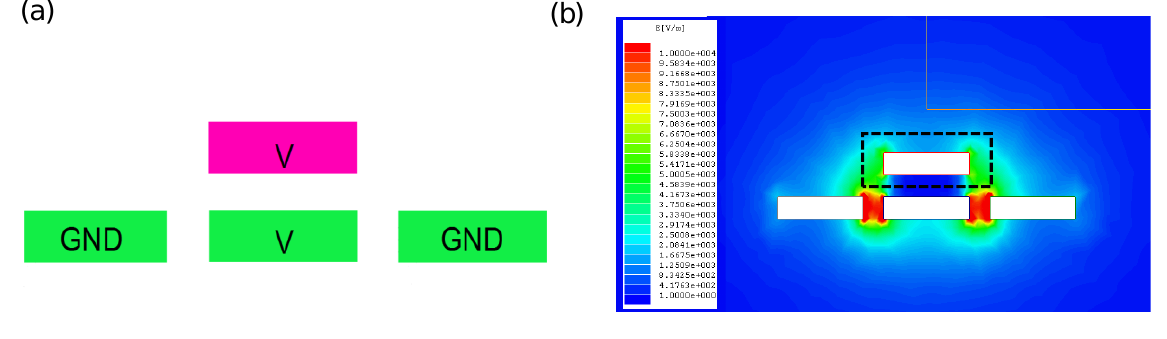
Figure 3. ( a ) Arrangement of electrode and application of voltage on different electrode to generate electrostatic repulsive force in prior art presented by our group [14,25,26]; ( b ) Simulated cross-sectional magnitude of the electrostatic field of the structure in a, when V = 100 Volts; Compared with Figure 3b (dashed rectangular region), electric field at the top face of central electrode in Figure 2b is larger, resulting in a larger electrostatic repulsive force.